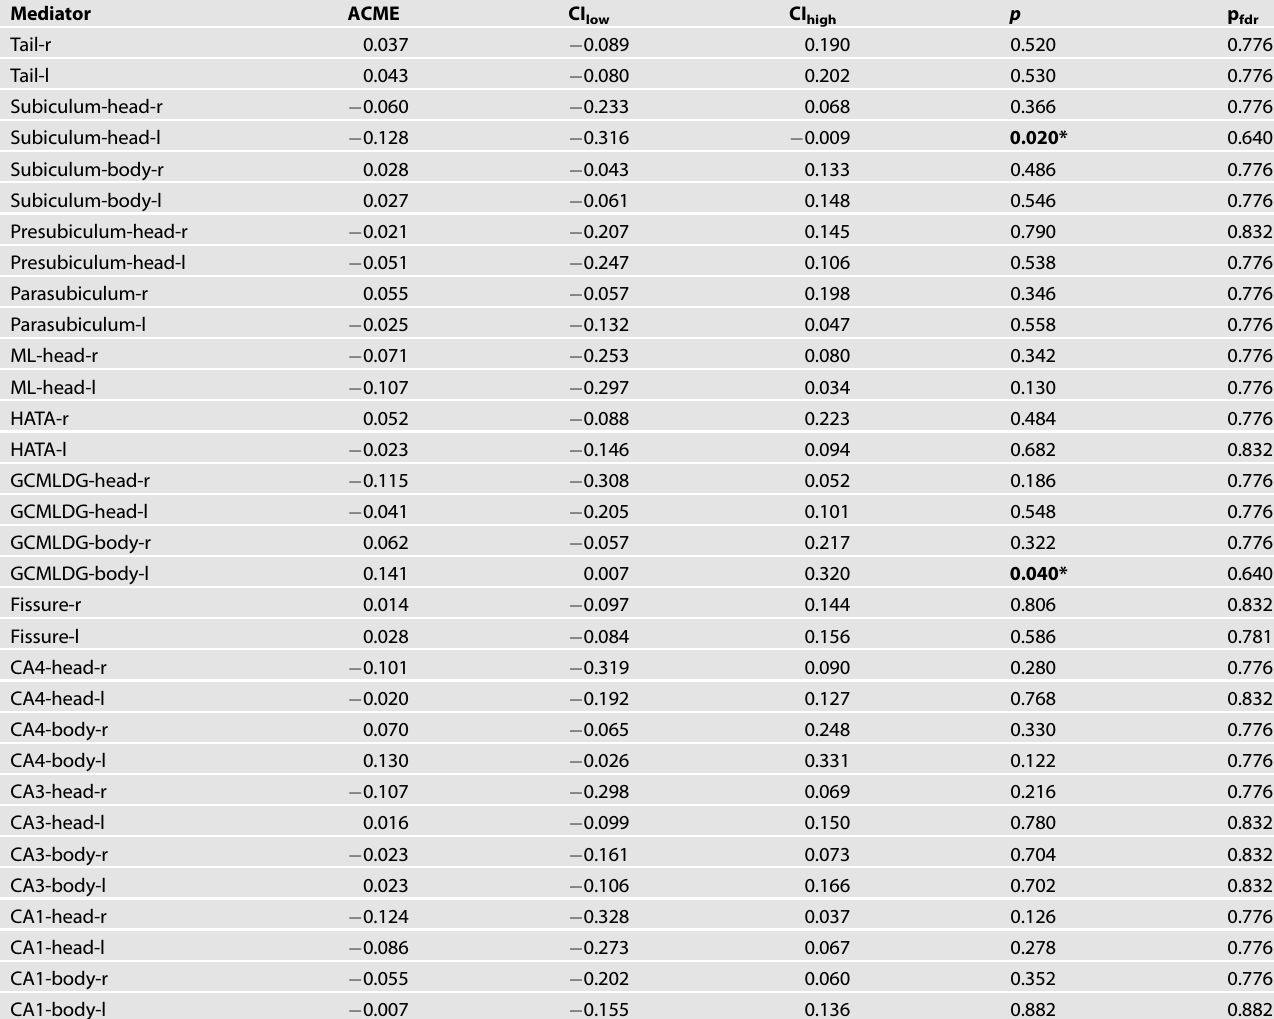
Table. 6. Mediation between aerobic fi tness, hippocampal formation sub fi eld volumes, and Verbal Learning and Memory Test long-term memory